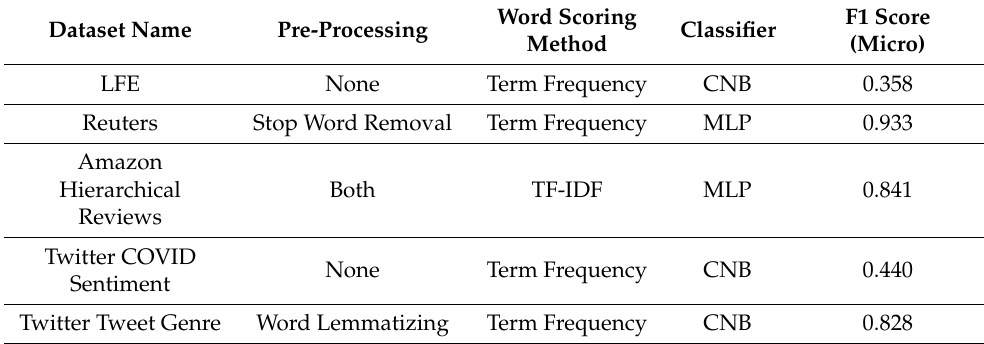
Table 6. Optimum pipeline result for each dataset with F1 micro averaged score.